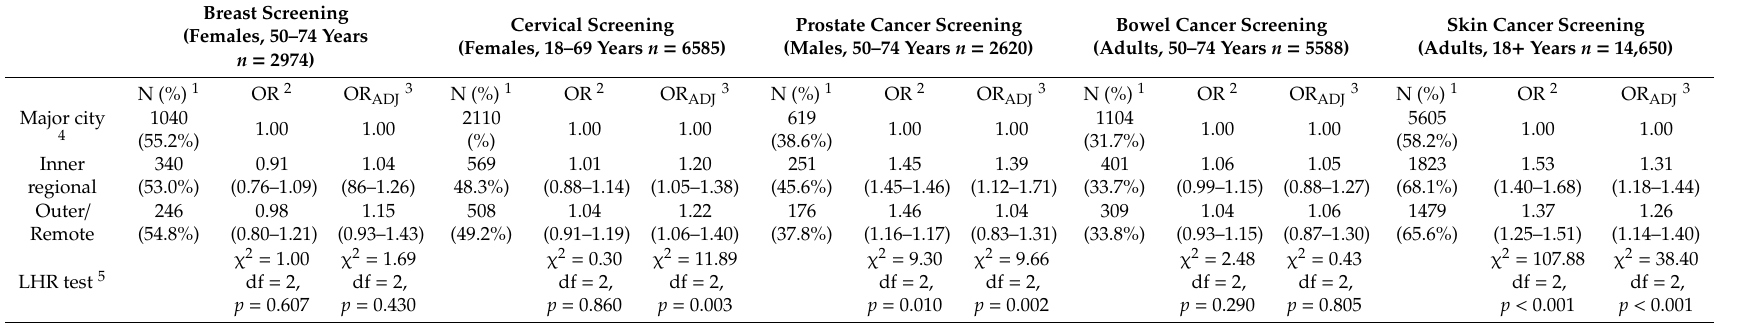
Table 2. Association between geographic remoteness and self-reported participation in screening activities.